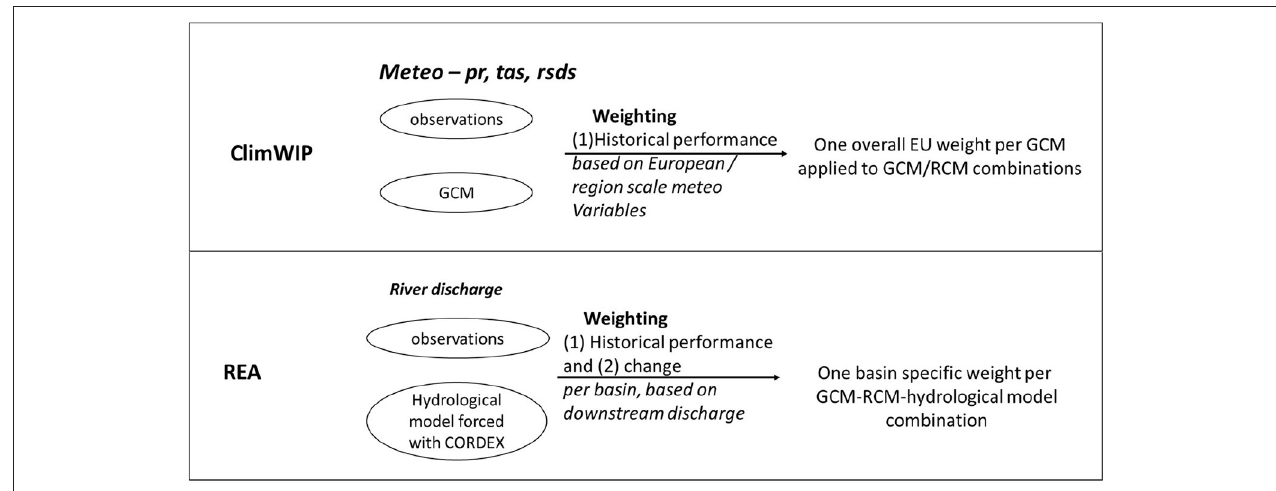
FIGURE 2 | Schematic overview of the Climate model Weighting by Independence and Performance (ClimWIP) and Reliability Ensemble Averaging (REA) methods.